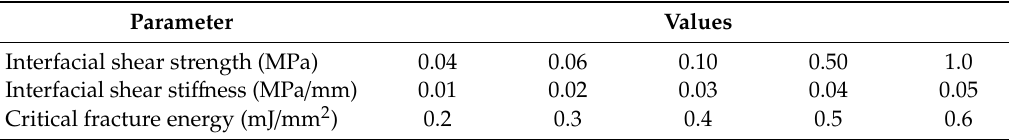
Table 5. Interface parameters of adjacent CCBP and